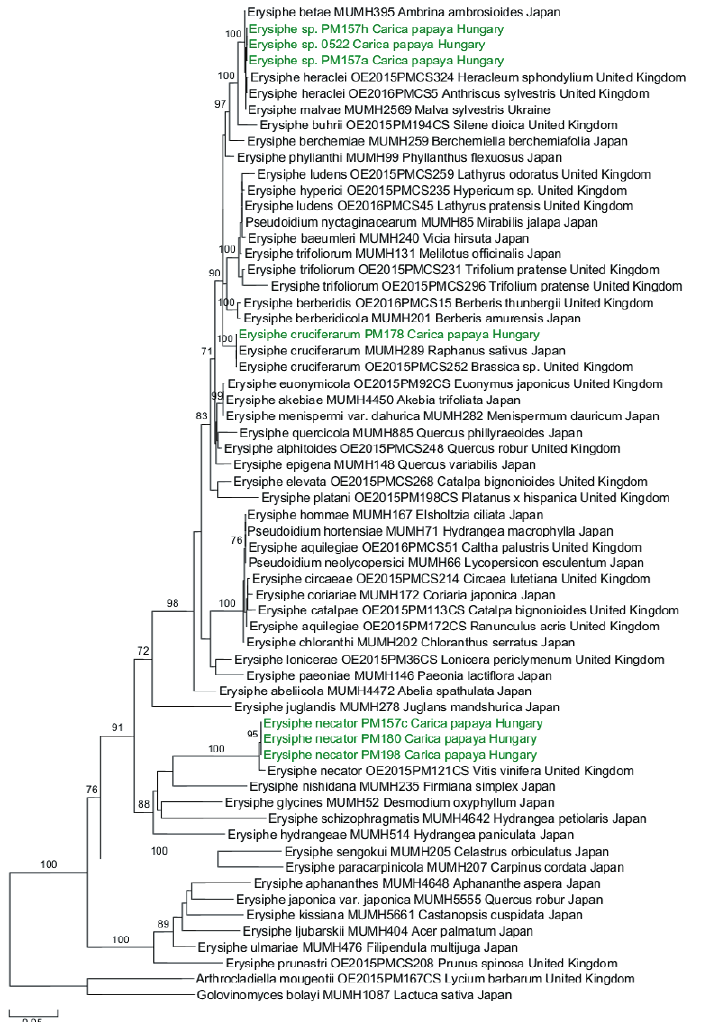
Figure 4. Phylogenetic tree with the greatest likelihood value resulting from the maximum likelihood (ML) analysis of ITS and mcm7 sequences of selected powdery mildew species belonging to the Microsphaera lineage of Erysiphe . Species names are followed by herbarium accession numbers (or GenBank accession numbers in parentheses if the herbarium accession number is not available), name of host plant, and country of collection. Samples collected in the present study are in green font. Bootstrap values were calculated from 1000 replicates in ML analysis (values below 70% and in subclades are not shown). Bar indicates 0.05 expected changes per site per